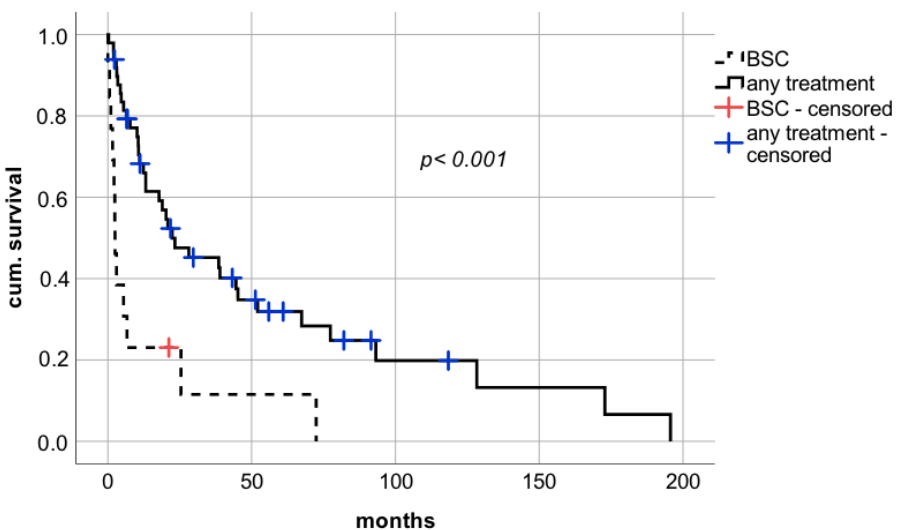
Figure 2. Impact of therapeutical strategies on survival diagnosis of de novo lung carcinoma after liver transplantation. BSC—best supportive care.